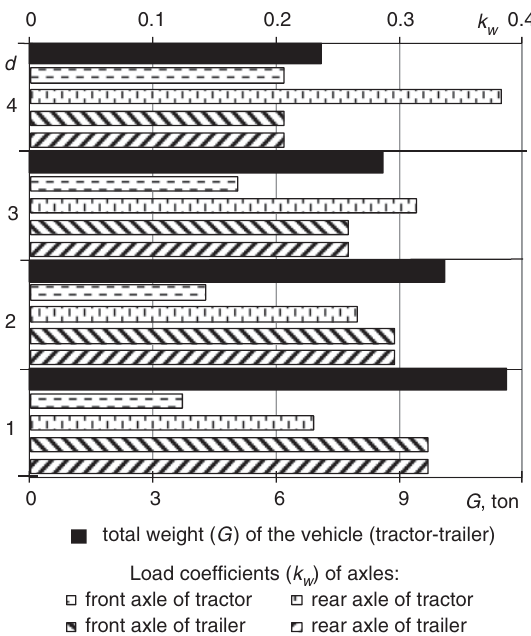
Fig. 4. Dependences of tractor wheels’ slippage on the load carried in the trailer when the trailer’s driving axles are